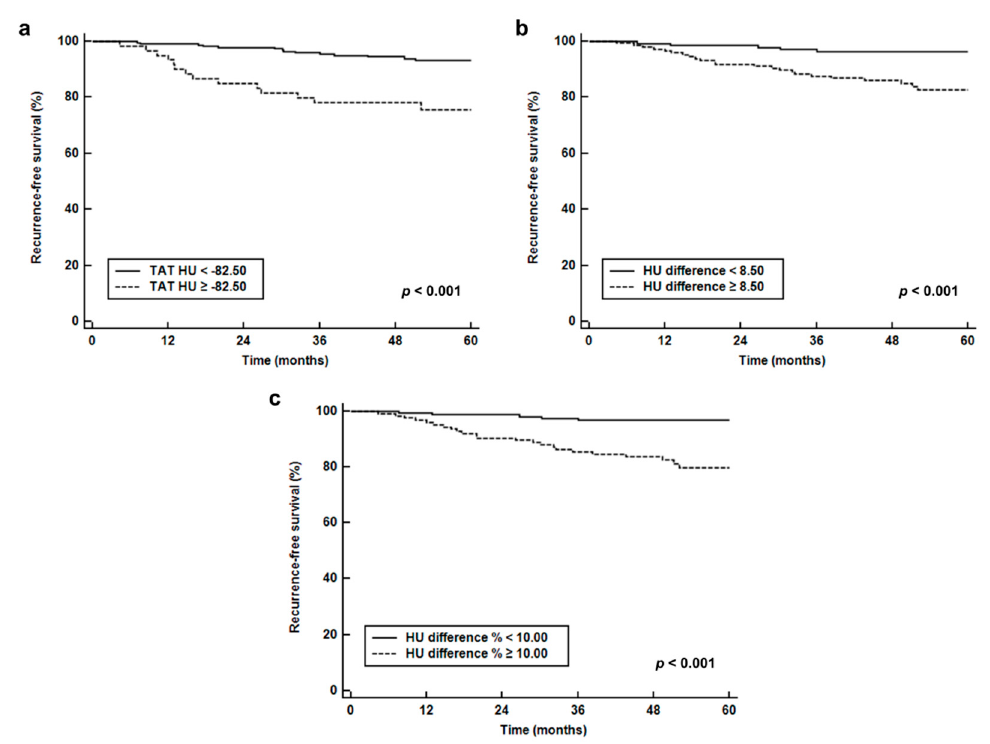
Figure 3. Survival curves. Recurrence-free survival stratified by CT-attenuation of tumor-adjacent breast adipose tissue (TAT HU) ( a ), difference of CT-attenuation (HU difference) ( b ), and percent difference of CT-attenuation (HU difference %) ( c ).